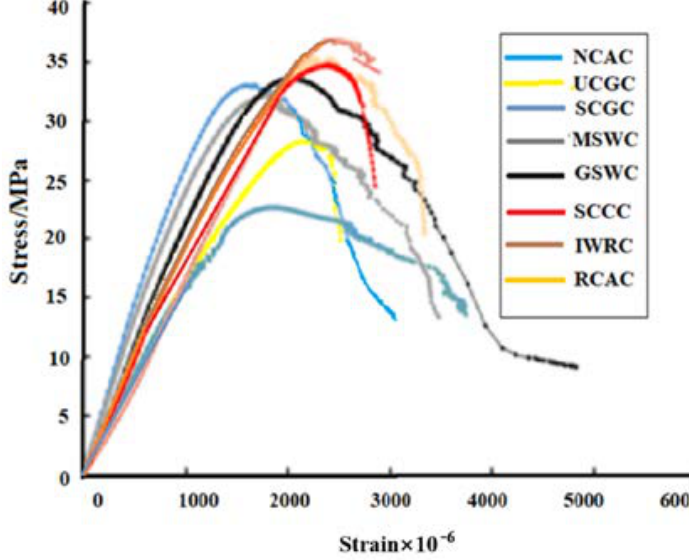
which makes the deformation larger, resulting in a larger peak strain and lower elastic modulus than the NCAC.